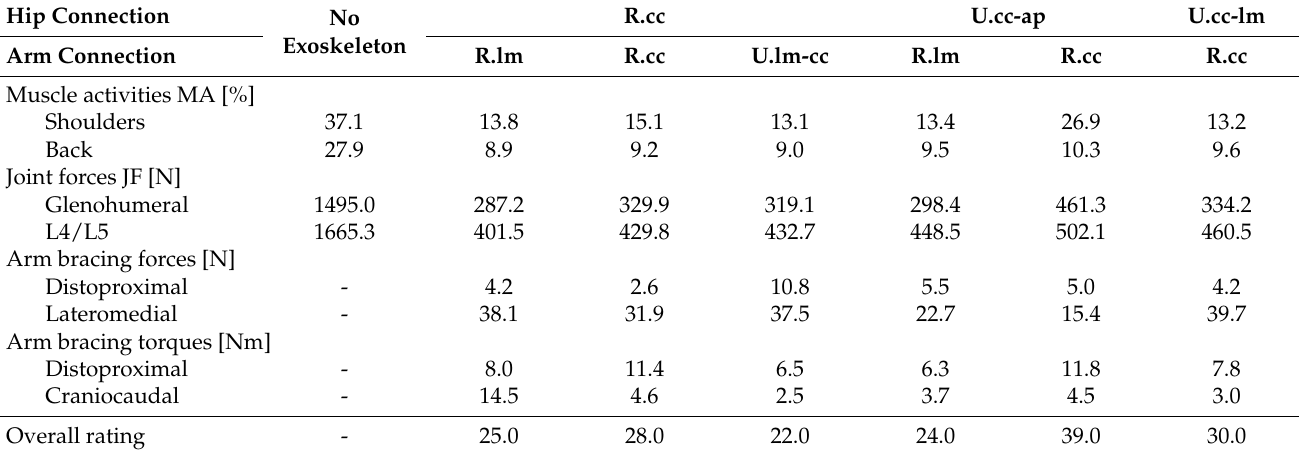
row shows the results of an overall rating of the concepts, with lower numbers indicating better